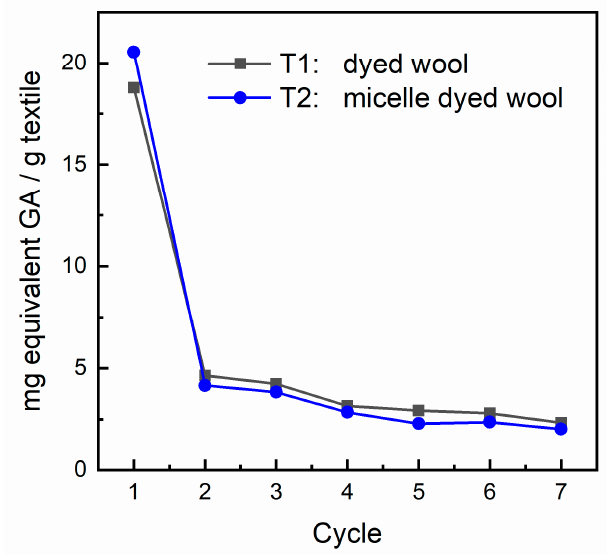
Figure 5. Release of the phenolic pool from the textile in an artificial sweat solution.